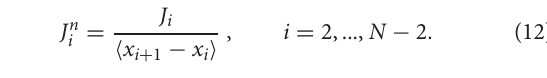
64, T L 1, T R 4. (Right) = = =